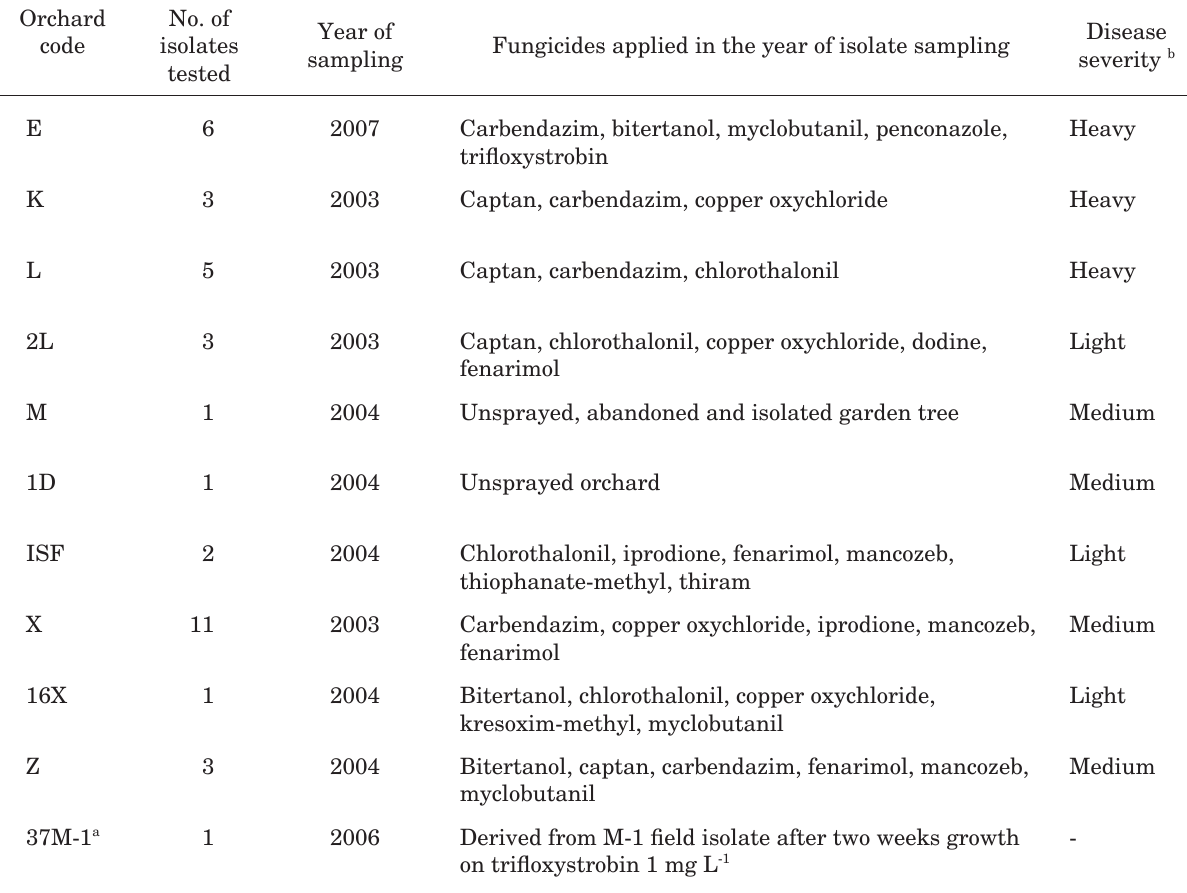
Table 1. Origin of Septoria pyricola isolates tested for their sensitivity to different fungicides in vitro.